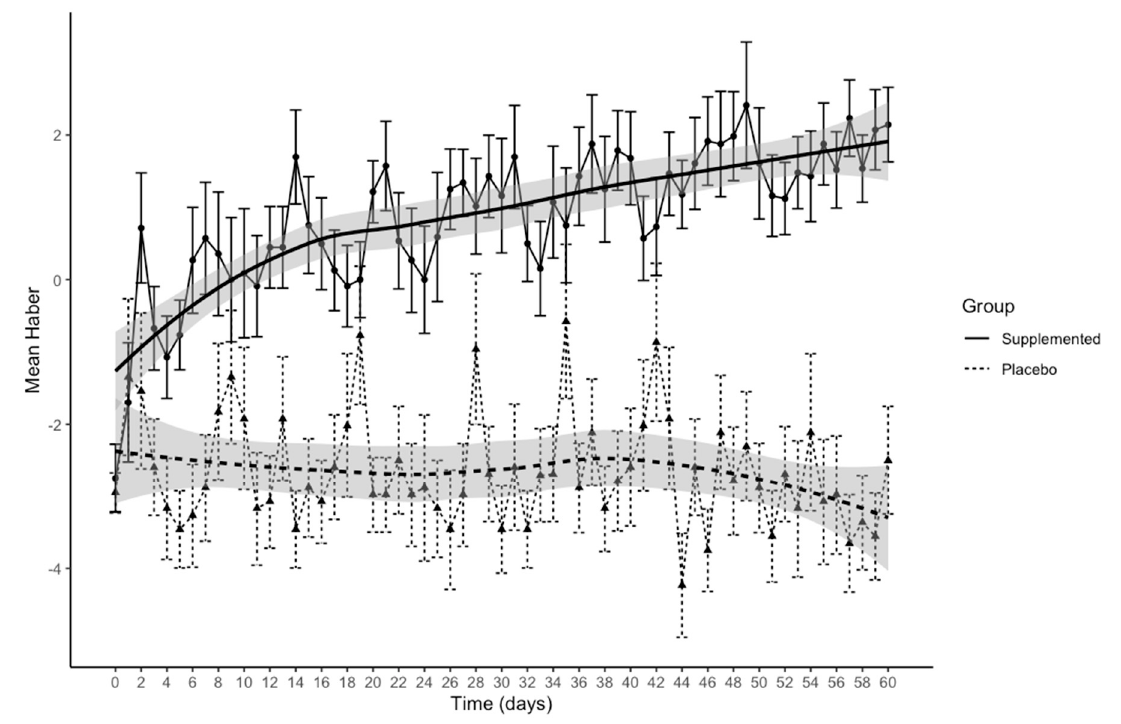
Figure 2. Patterns of changes in Haber’s mean scores versus time for 60 days for satiety in the supplemented and placebo groups, with a Loess smoothing curve and its 95% confidence interval (grey). Error bars indicate the standard error of the mean. Table 8. Within- and between-group differences in satiation (Haber’s